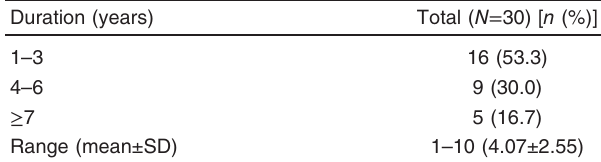
Table 2 Duration (years) distribution of the study